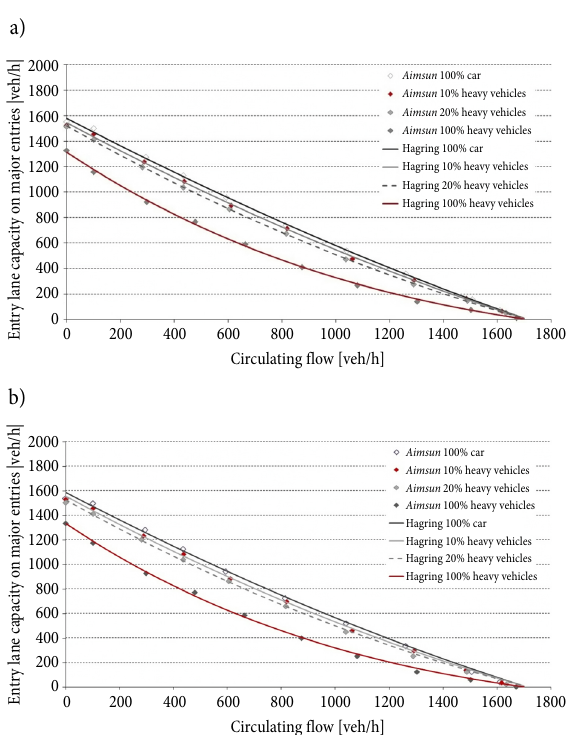
Fig. 5. Simulated points and capacity functions for the base and mix curves: a – the left-lane on major entries; b – the right-lane on major entries